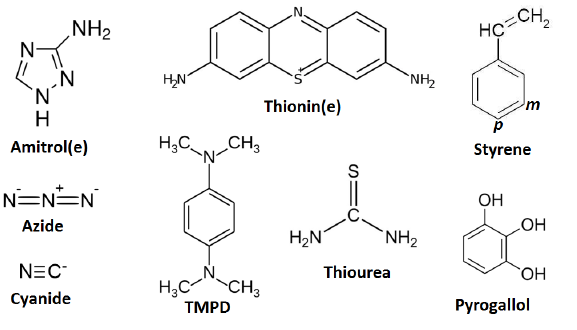
Scheme 4: Structure of ligands and (pseudo)substrates